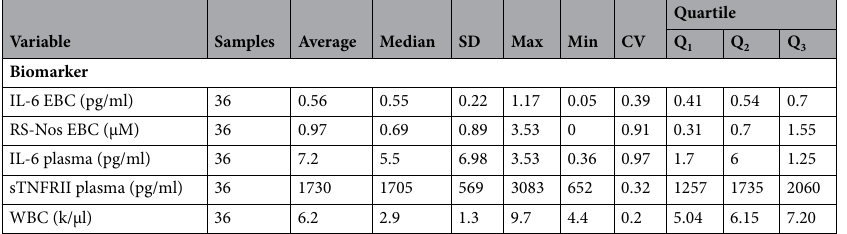
Table 5. Description of measured biomarkers in the first sampling period (March-winter).